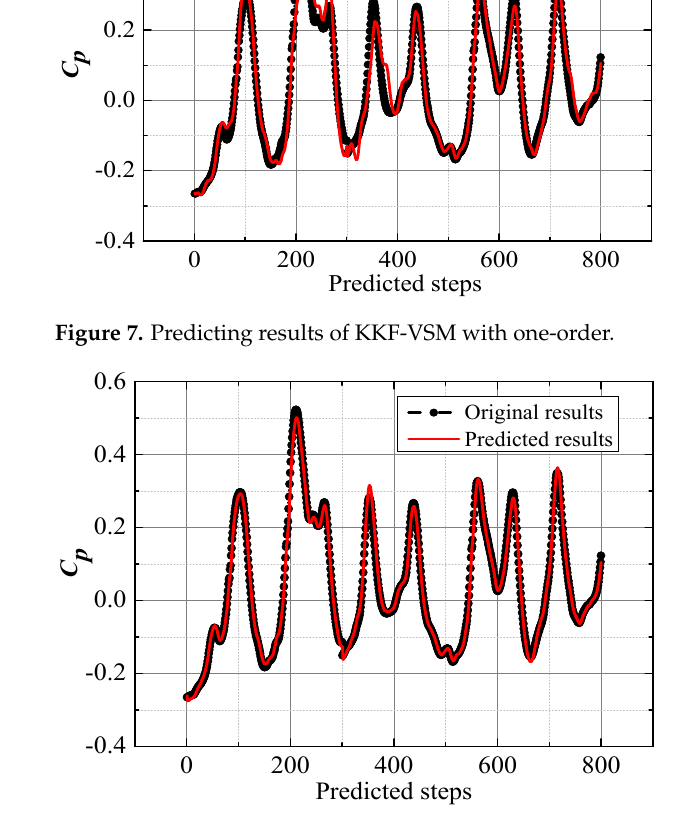
Figure 8. Predicting results of KKF-VSM with two-orders.